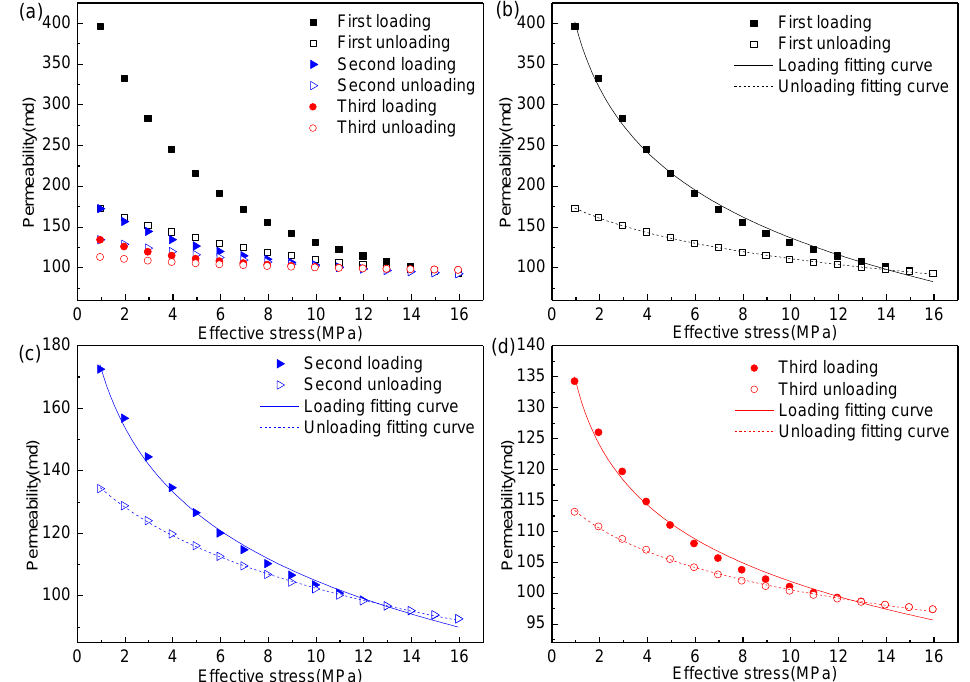
Figure 4. The test results and fitted curve showing the permeability and effective stress on broken coal samples under cyclic loading and unloading conditions: ( a ) the test result showing the permeability and effective stress on broken coal samples under cyclic loading and unloading conditions, ( b ) the fitted curve of permeability and effective stress during the first loading and unloading, ( c ) the fitted curve of permeability and effective stress during the second loading and unloading, ( d ) the fitted curve of permeability and effective stress during the third loading and unloading. Table 2. The fitting equations of permeability and effective stress on broken coal samples under cyclic loading and unloading conditions.